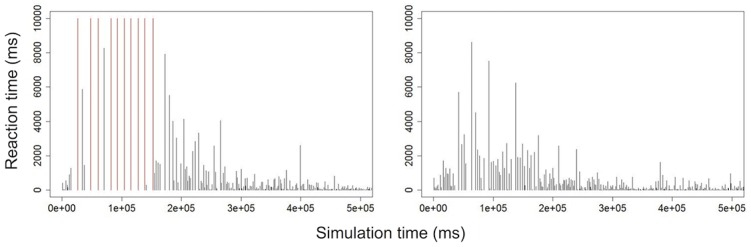
Evolution of the reaction times of 2 successful neural networks at the selective learning task.20 networks were simulated, 18 of which successfully learned the task (Table 1). Red lines represent when there was no response from the network. A learning curve is clearly visible.